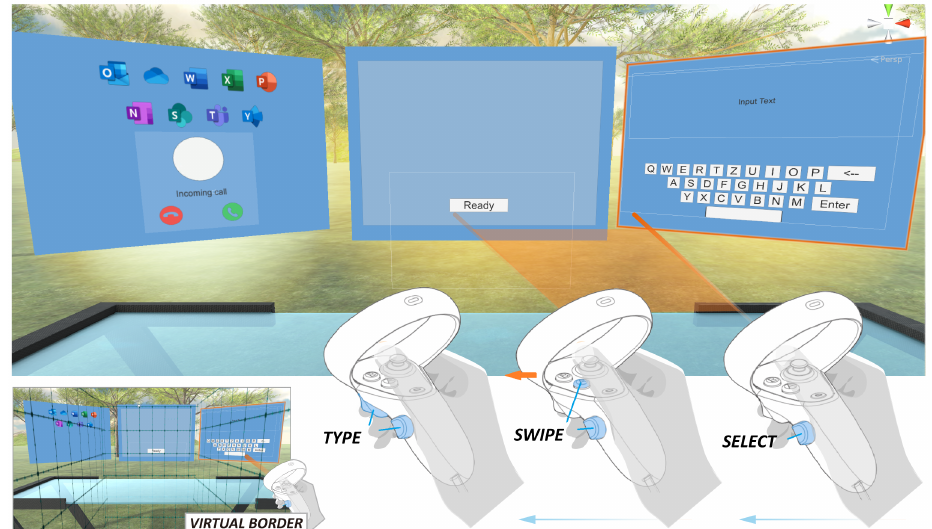
Figure 2. Interaction (select, swipe, and type) on the Oculus controller for productivity tasks in the rear-seat virtual reality (VR) workplace. In the Border condition, a virtual grid appeared (bottom-left) when users were too close to the physical border/interior of the